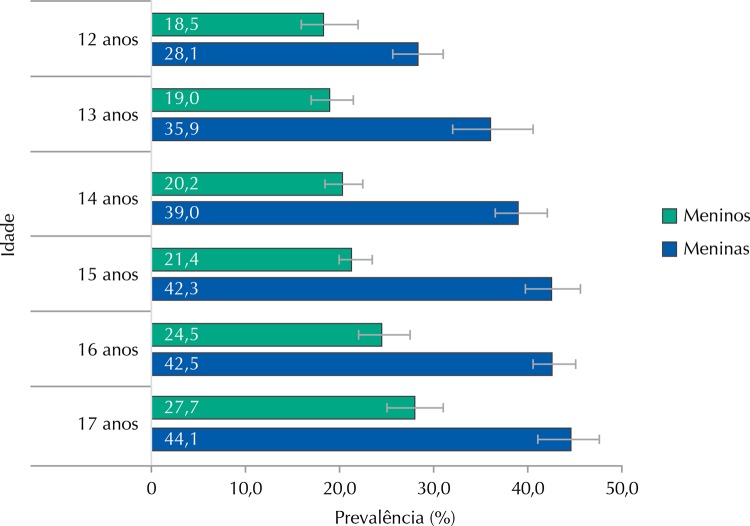
Prevalência e IC95% de transtorno mental comum nos municípios de mais de 100 mil habitantes por sexo e idade. ERICA, Brasil, 2013-2014.